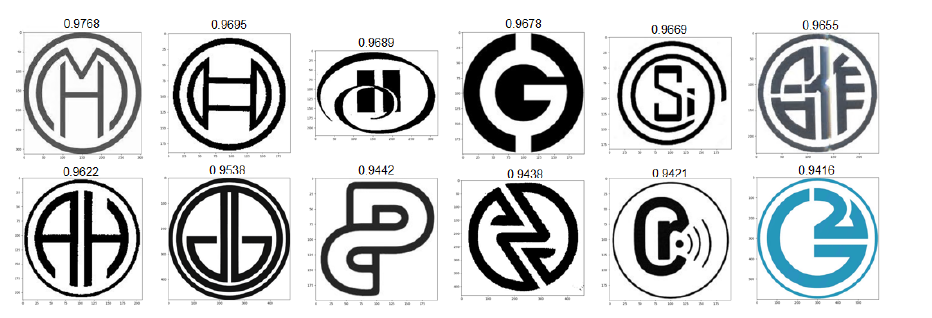
Figure 11. Top-12 result set for input B.